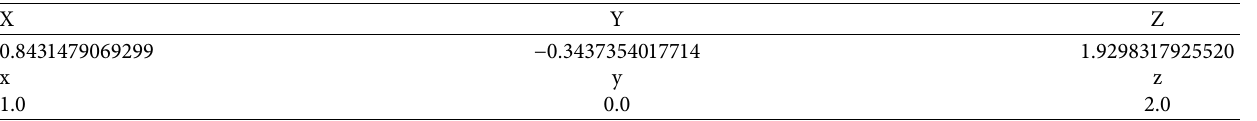
Table 5: Solution of the initially unknown confguration and aim confguration of the 3-bar structure in Figure 19 with nonlinear truss elements.